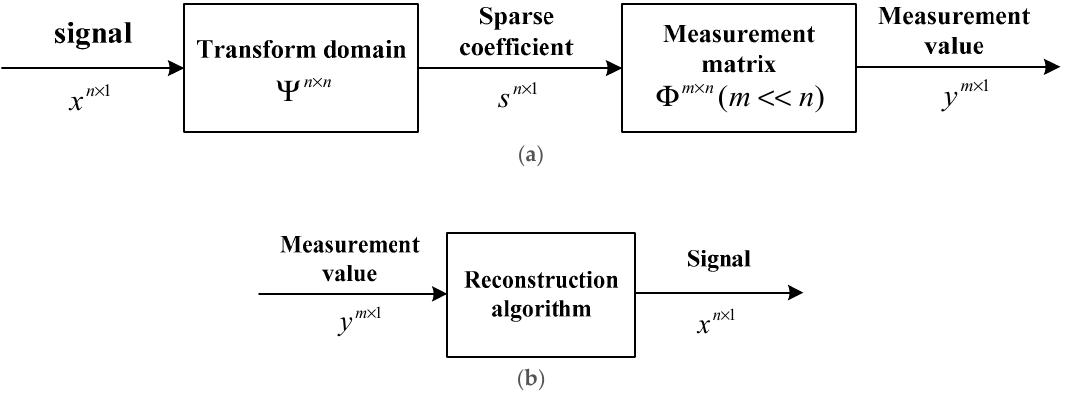
Figure 1. Compressive Sensing process of signal ( a ) compression of signal; ( b ) reconstruction of signal